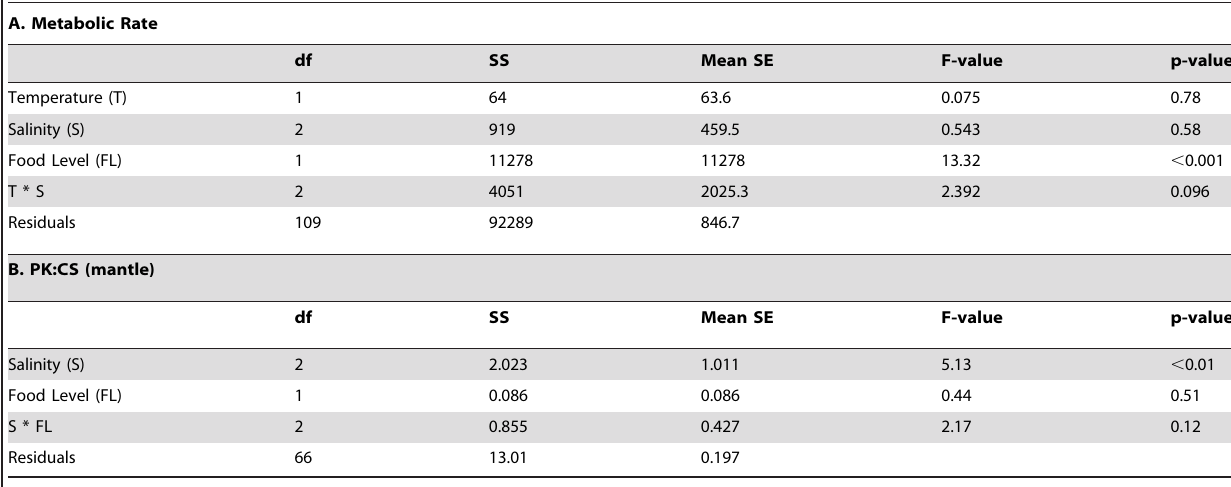
Table 1. Results of multiple linear regressions to determine the effect of experiment, temperature, salinity, and food level on